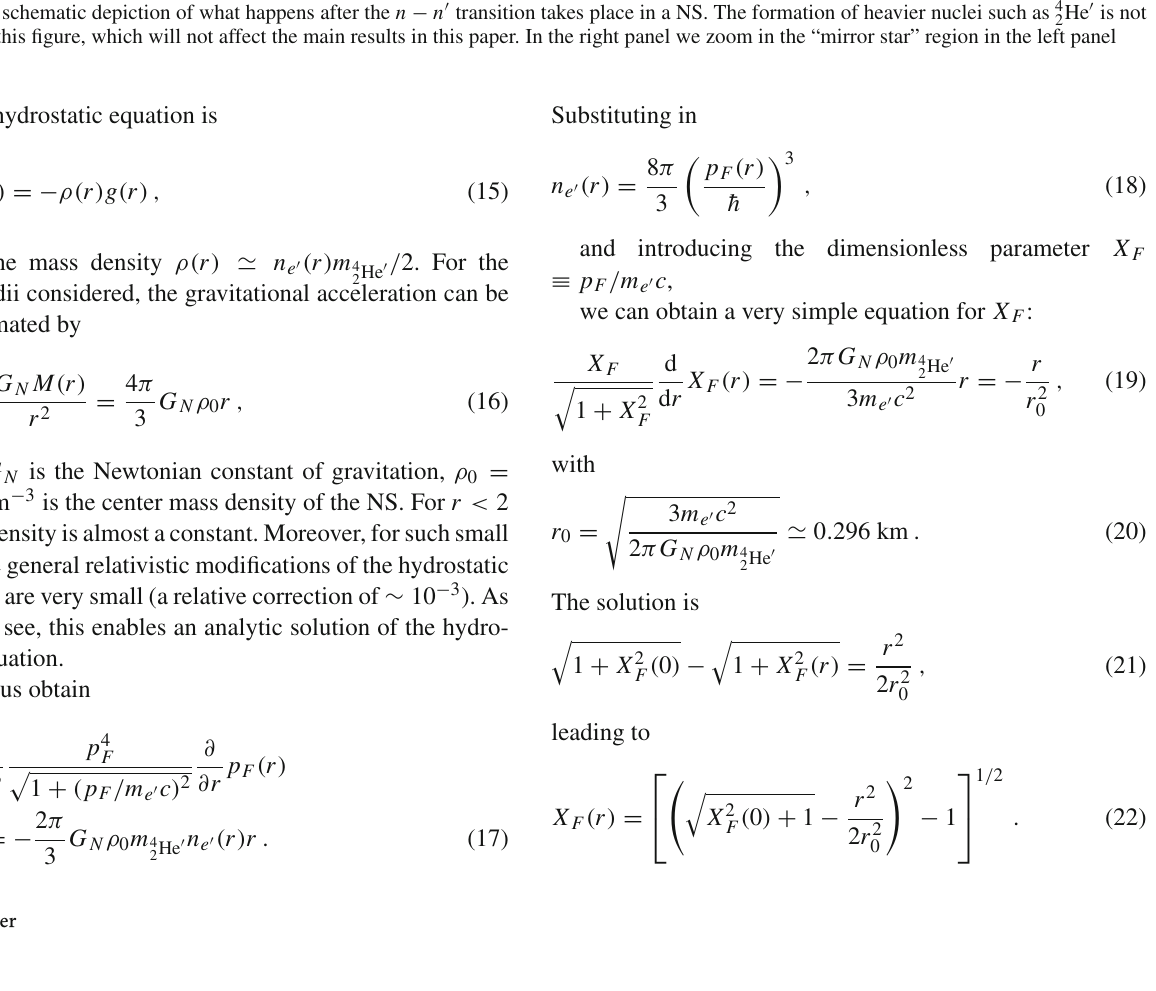
He (cid:2) is not 2